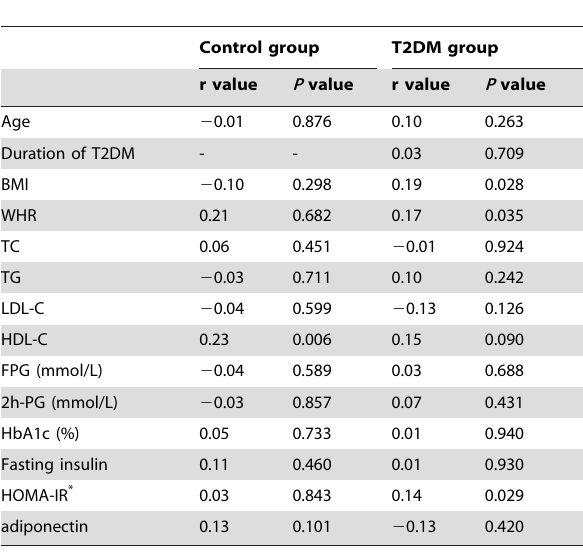
Table 2. Results of Pearson correlations of vaspin with clinical and biomedical indices at